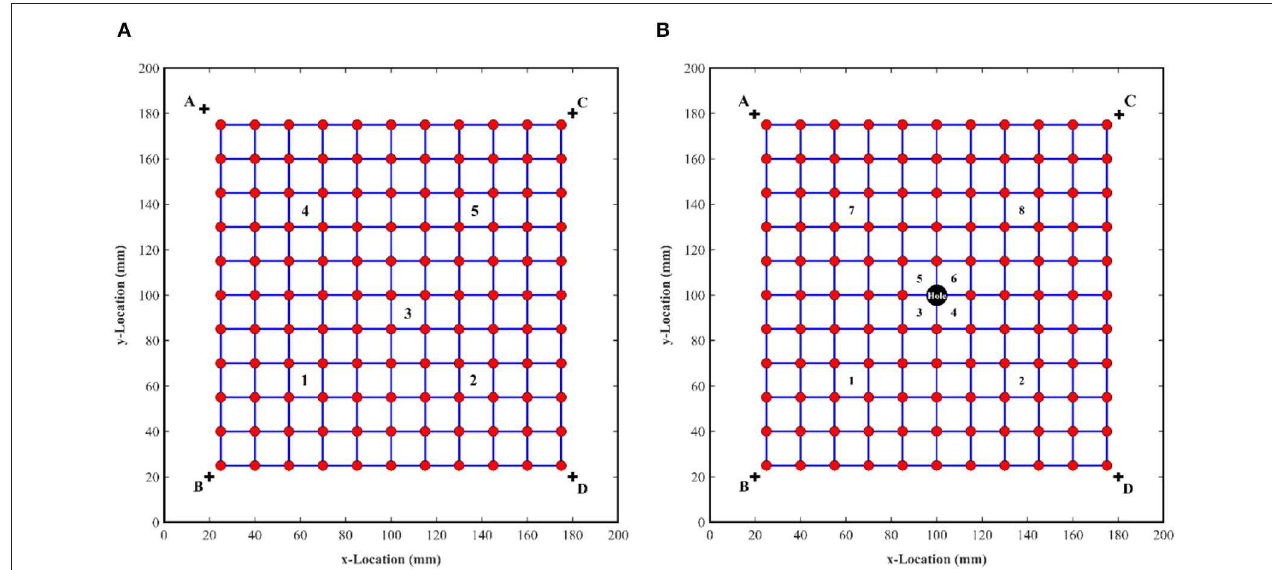
FIGURE 5 | Calculated and actual impact locations for the CoG method (A) and the new topological MA approach (B) applied to TR with cell-centered impacts and no grid refinement.